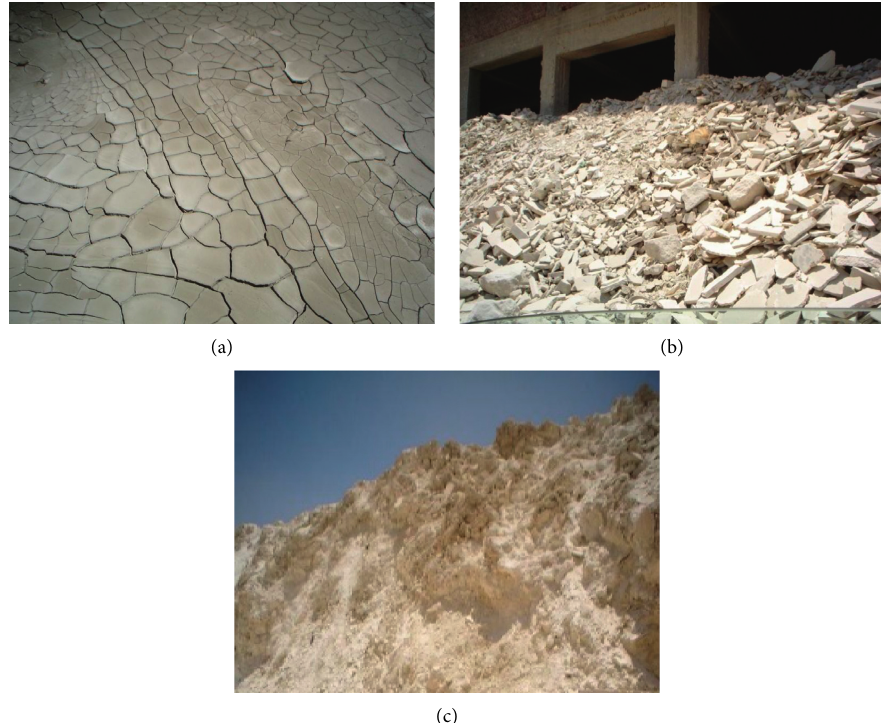
Figure 3: Different shapes of marble wastes resulted from marble factories in the Shaq Al-Thouban region. (a) Slurry state. (b) Solid State. (c) Dust state.